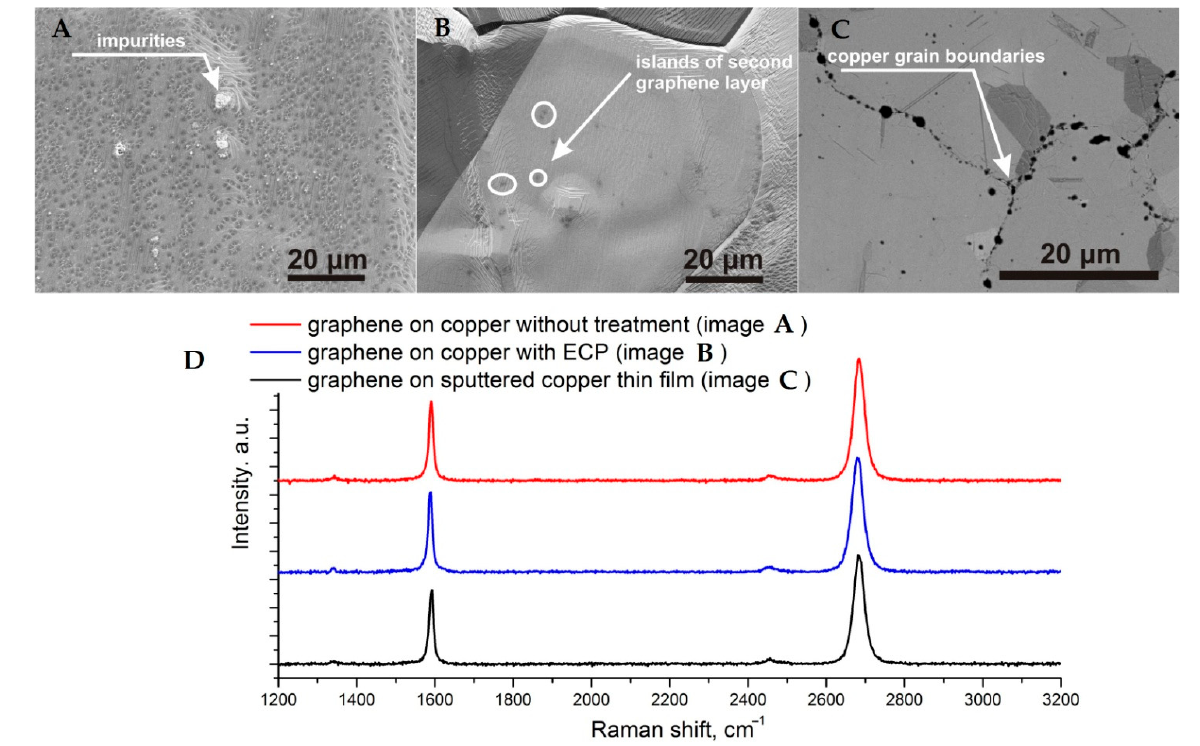
Figure 5. SEM images and Raman spectra ( D ) of graphene films synthesized on copper foils with different treatment (( A ) — without pre-treatment, ( B ) — polishing) and ( C ) — deposited copper.